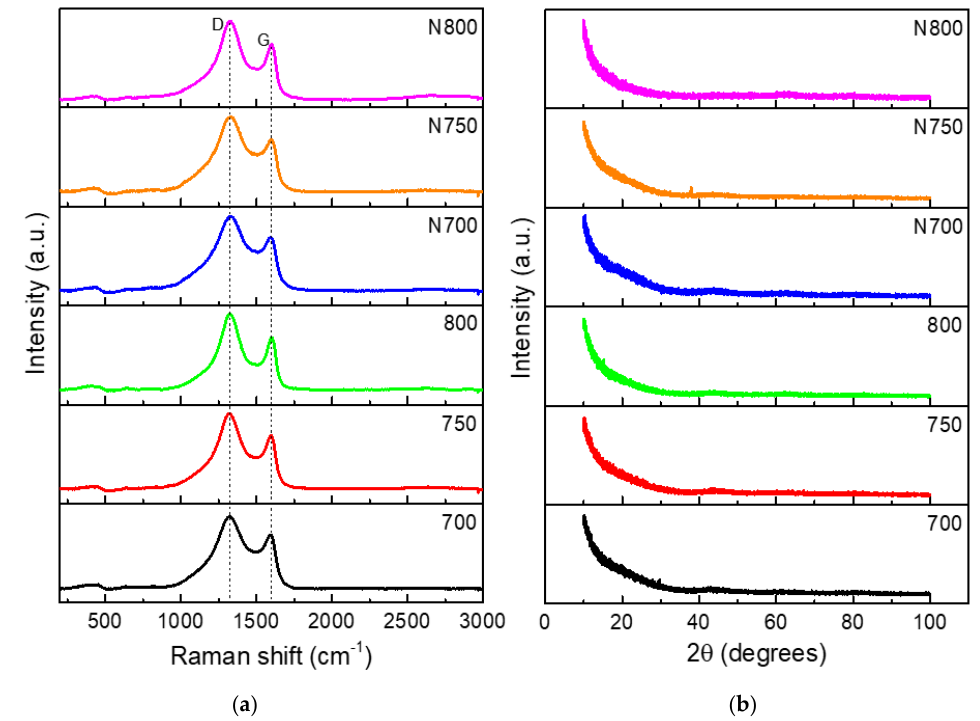
Figure 3. ( a ) Raman spectra and ( b ) XRD patterns of electrocatalysts synthesized from Sargassum spp. at different temperatures.